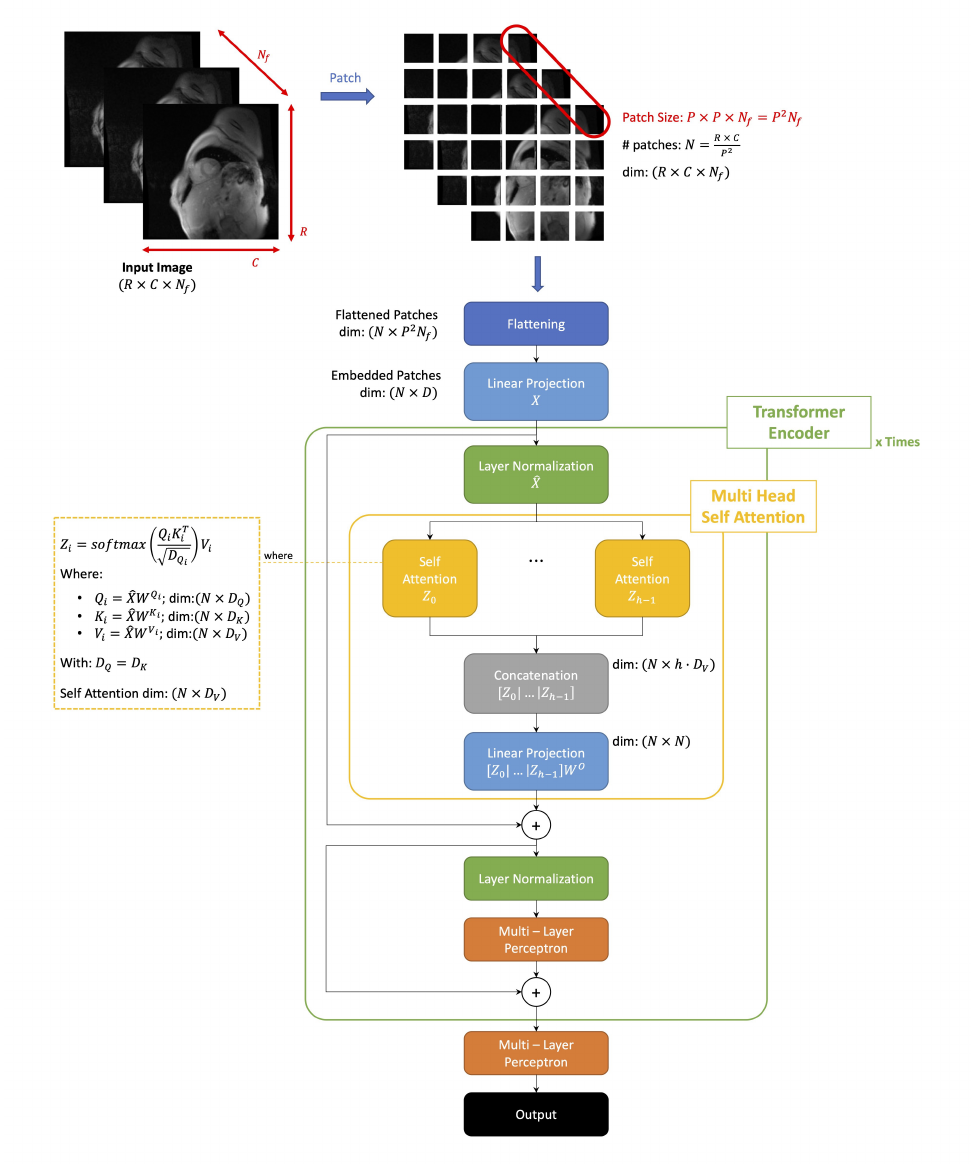
Figure 2. Visual transformer general architecture. Our model receives as input multi-echo CMR sequences and predicts a bounding box to detect the left